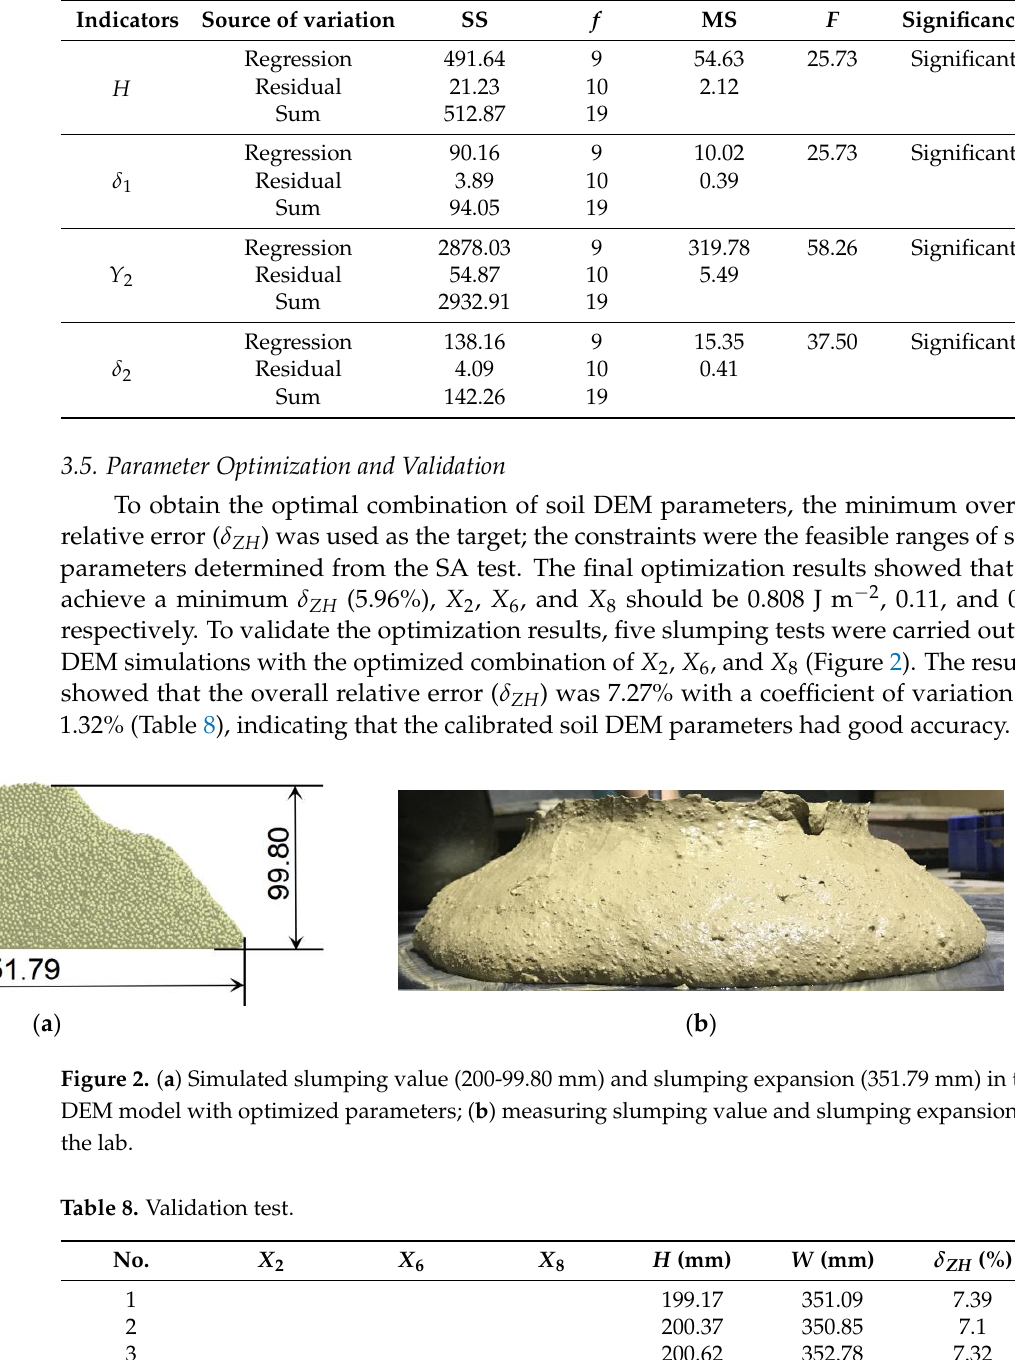
Table 7. Variance analysis of the regression equations.